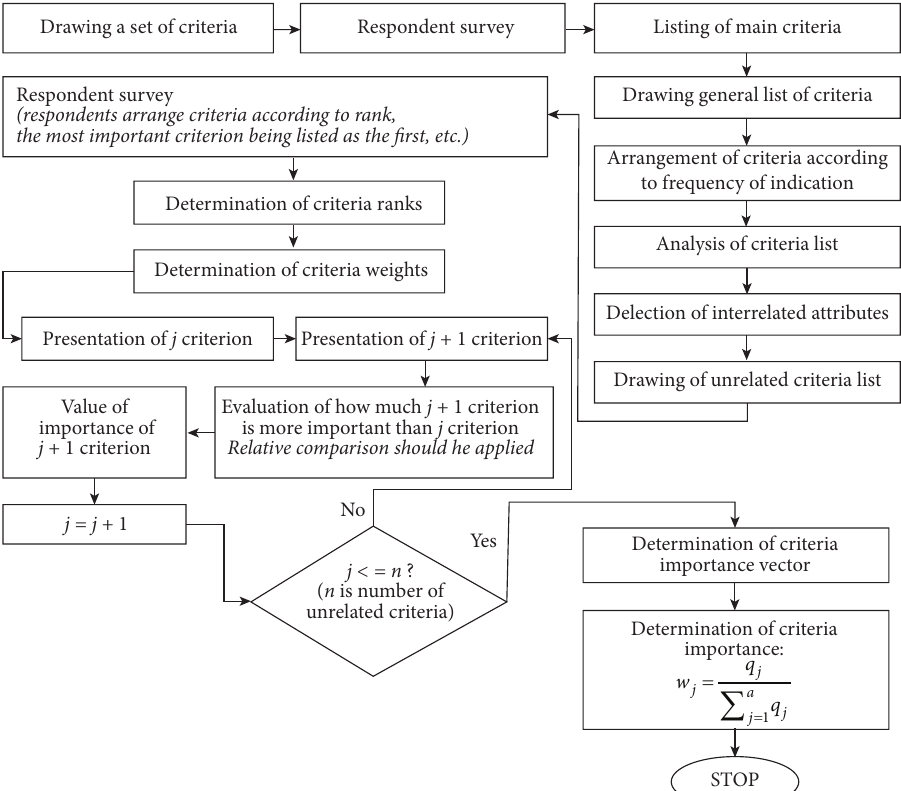
Figure 2. Determining of the criteria weights based on